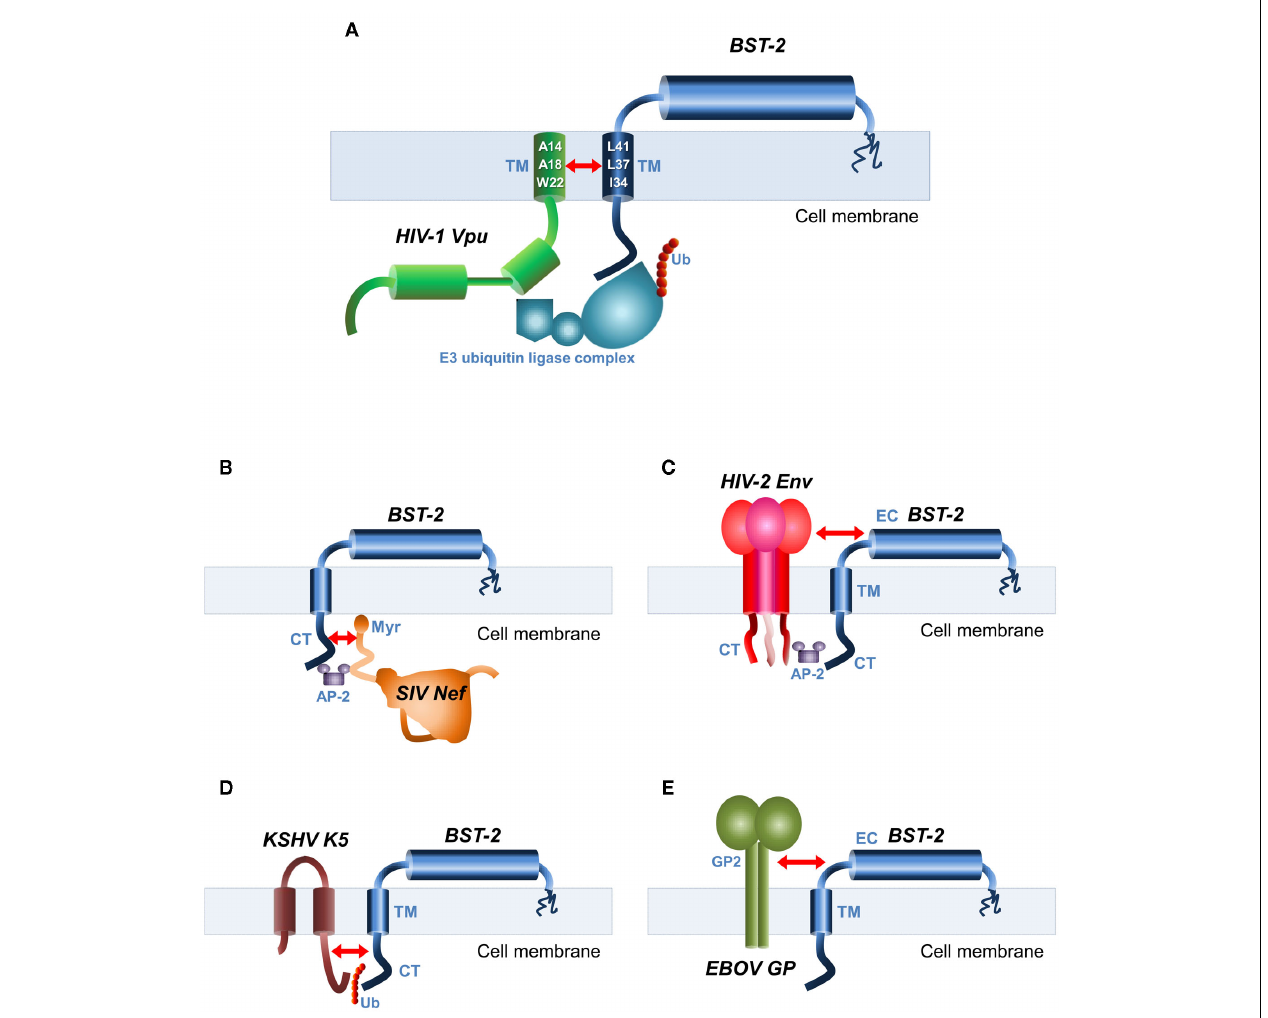
Myr, myristoylation site. (C) The envelope glycoprotein (Env) of HIV-2 and SIVtan binds to BST-2 through their mutual ectodomains (EC), and recruitment of AP-2 by the CT domain of Env required for internalization is also shown. (D) Kaposi’s sarcoma-associated herpesvirus (KSHV) K5 protein that is an ubiquitin ligase ubiquitinates a target lysine motif in the CT domain of BST-2, resulting in its internalization. (E) The antagonistic mechanisms of the Ebola virus (EBOV) glycoprotein (GP) are unclear, but require interaction between GP2 subunit of EBOV–GP and BST-2